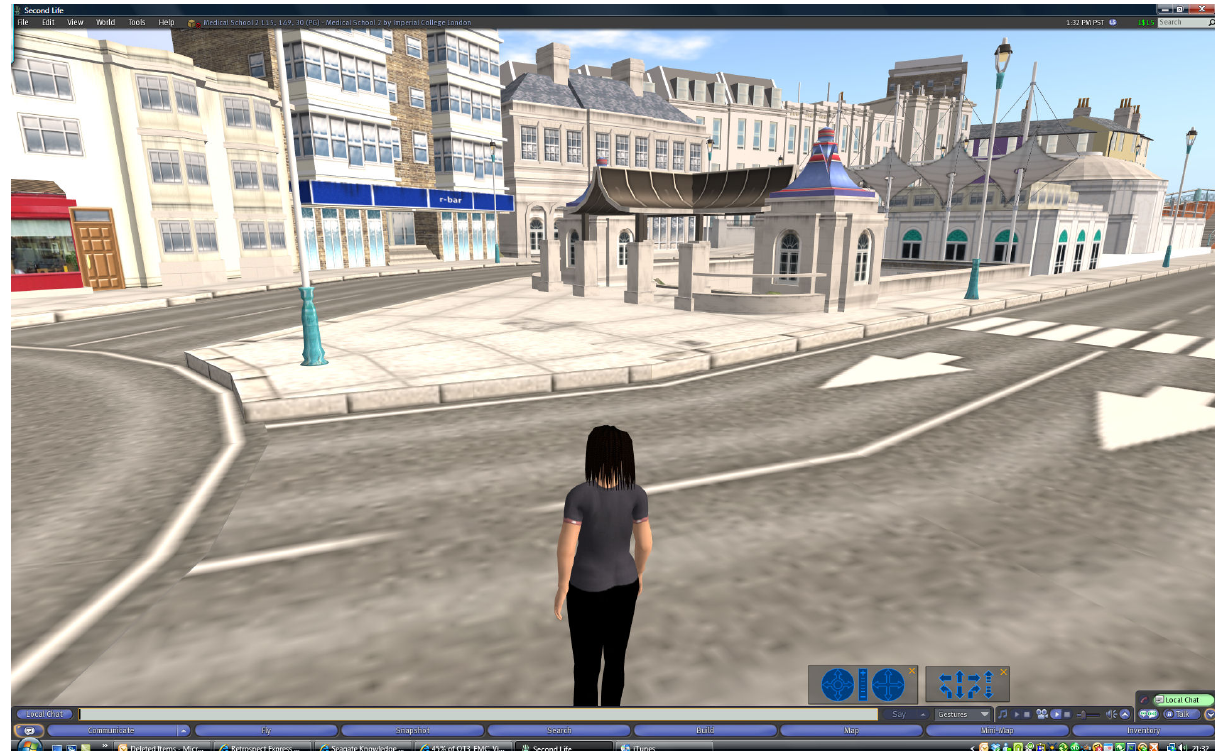
Figure 1. Screenshot of opening scene showing key landmarks and standard female